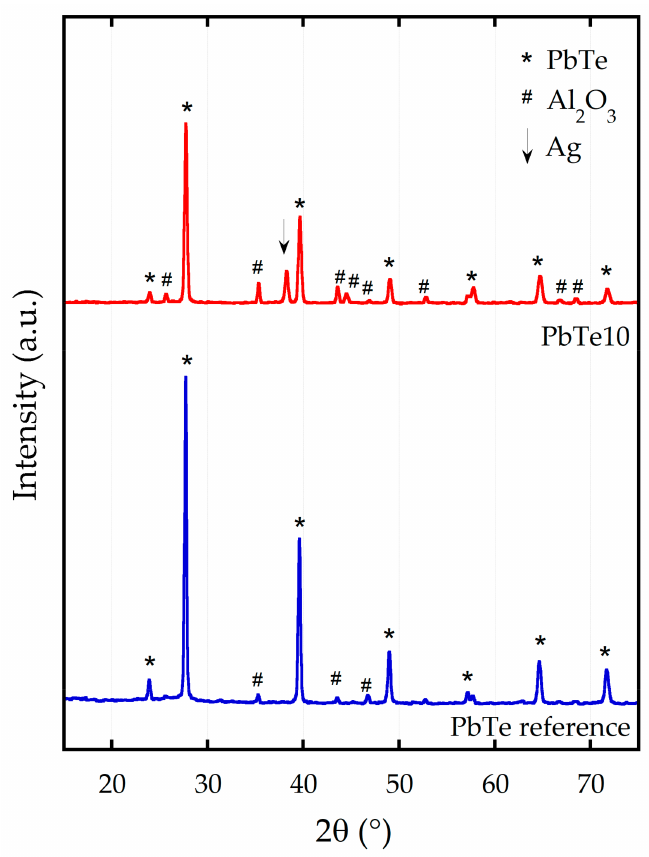
Figure 4. µ -XRD patterns taken at grazing incidence angle of the undoped PbTe, used as a reference, and the sample